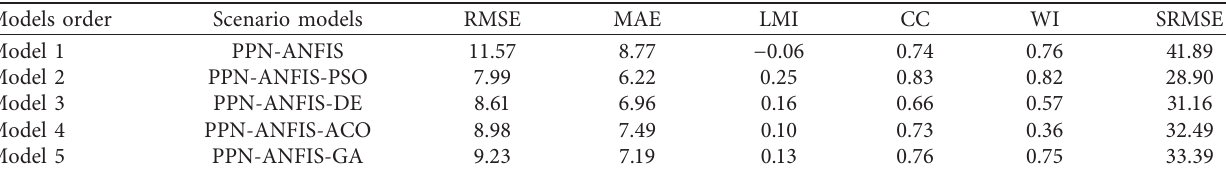
Figure 4: The related geo-science input parameters and the output ground settlement. Table 2: The statistical evaluation of the developed hybrid and original ANFIS for the scenario of the preprocessed and normalized (PPN) dataset over the testing phase of the modeling.